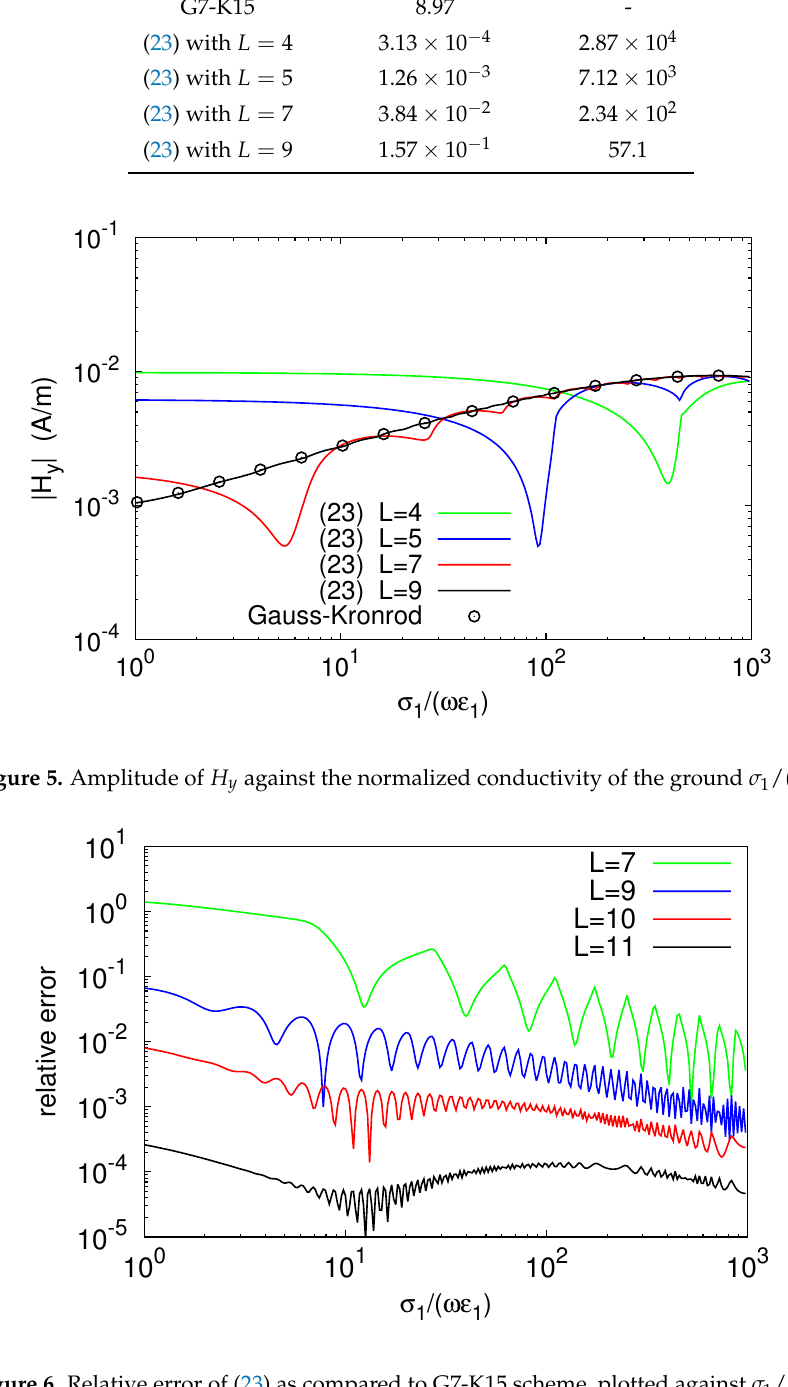
Figure 6. Relative error of (23) as compared to G7-K15 scheme, plotted against σ 1 / ( ω(cid:101) 1 )